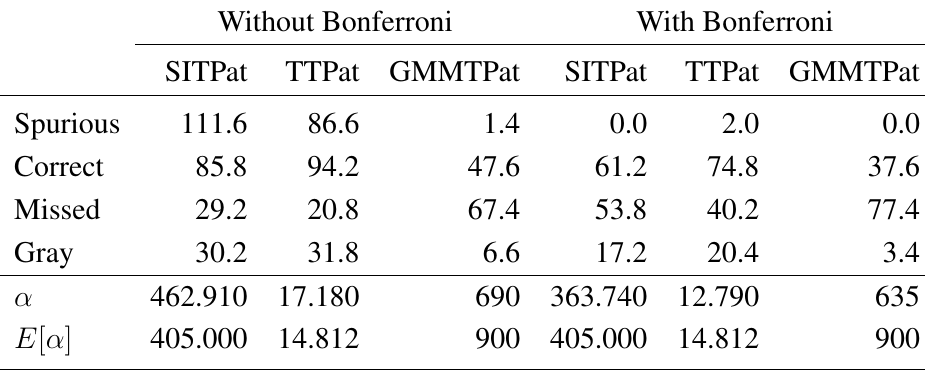
Table 2. Comparative evaluation of GMMTPat